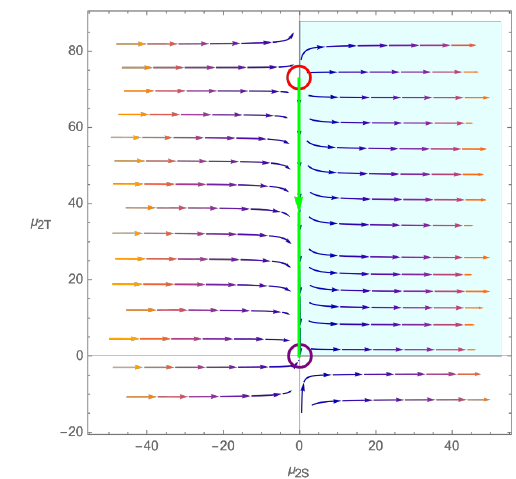
(a) Single trace flow. Fixed flows determine pa- (b) Double trace flow, coarse grained view, De- rameters for double trace flows. tails are resolved in figure 3. Figure 1. RG flows for M = 425 . UV stable fixed flows are marked with purple circles, IR stable fixed flows with red circles and fixed flows of mixed stability with green circles. They are connected by (green) separatrix flows. Cyan flows and regions mark other models for which the one loop approximation also makes sense in the IR.